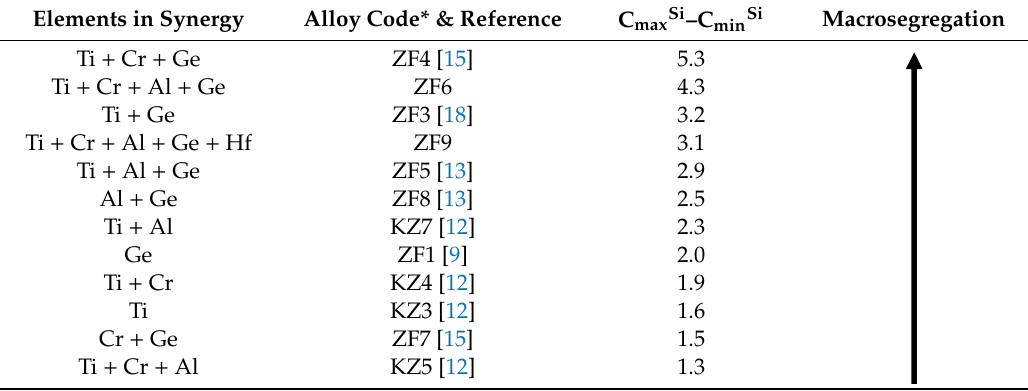
Table 6. Synergistic e ff ect of alloying elements on macrosegregation of Si in as cast Nb-18Si silicide-based alloys.